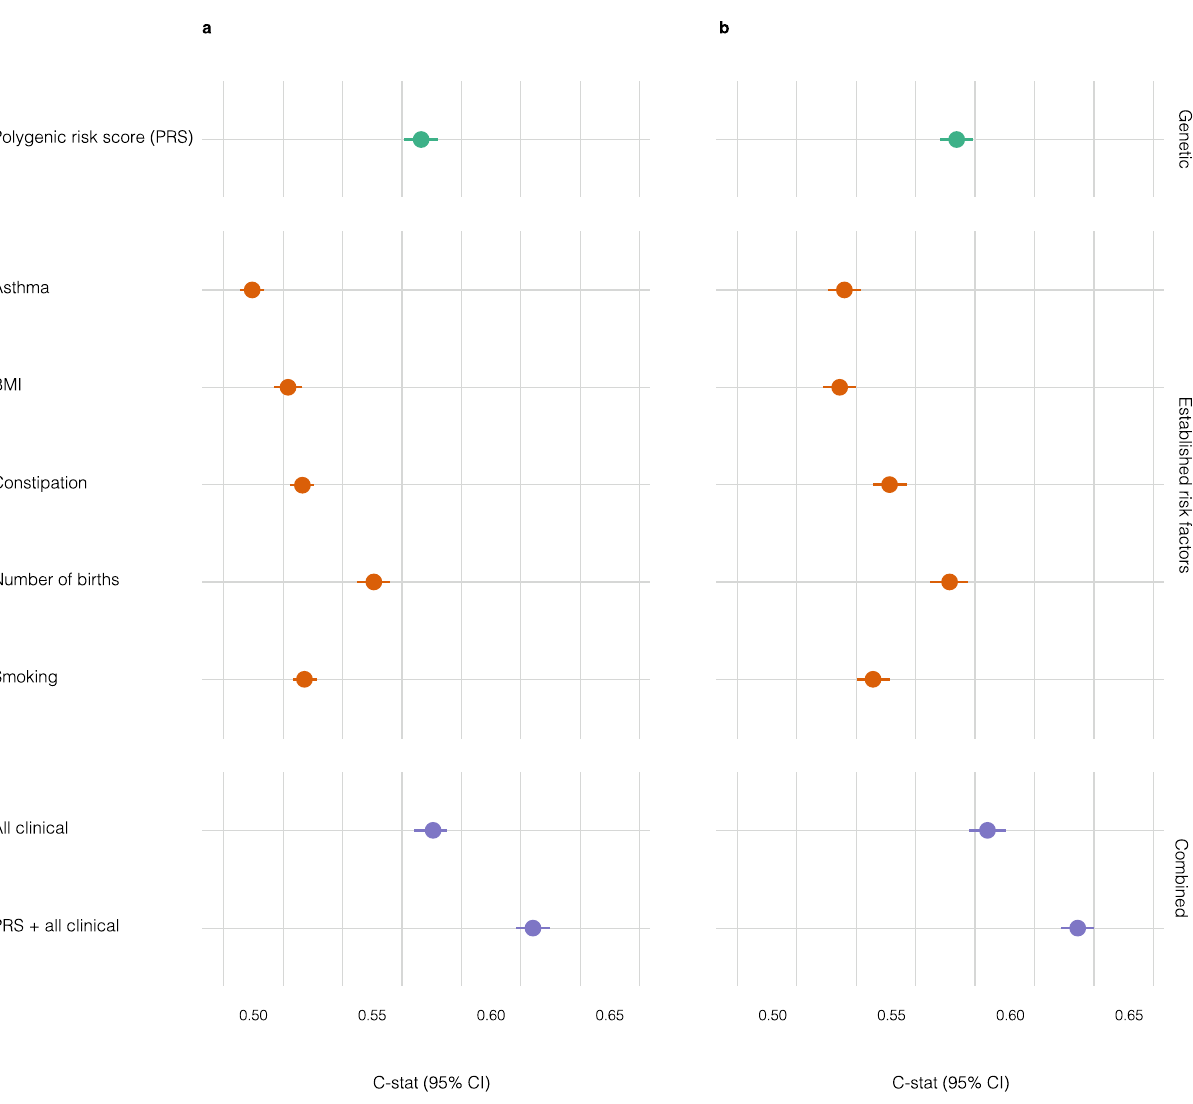
Fig. 5 Predictive ability of PRS and clinical variables in incident status. Green dots represent polygenic risk score (PRS), orange dots represent fi ve established risk factors and purple dots represent genetic and/or clinical combined models C-statistic (C-stat) indexes. Data are presented as means + / − SEM in both panels. Cox proportional hazard models were used and age was used as a time scale for properly accounting for left-truncation and right- censoring in the data in both models. a C-stat for clinical variables and PRS alone or in combination in the validation subset of Estonian Biobank (2104 cases and 24,753 controls). b C-stat adjusted by batch effects and 10 fi rst principal components in the validation subset of Estonian Biobank (2104 cases and 24,753